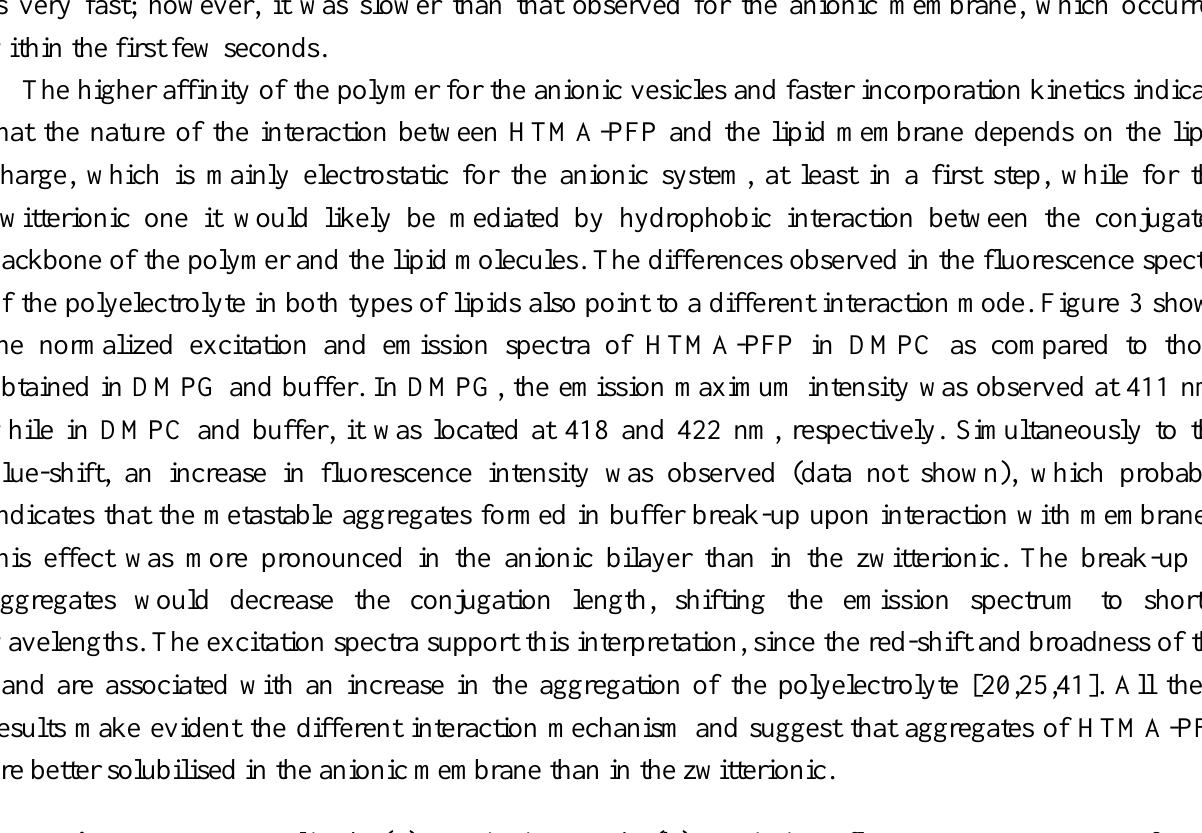
3. Normalized ( a ) excitation and ( b ) emission fluorescence spectra of HTMA-PFP in buffer (blue dotted line), LUVs of DMPC (black line) and LUVs of DMPG (red dashed line) recorded at 40